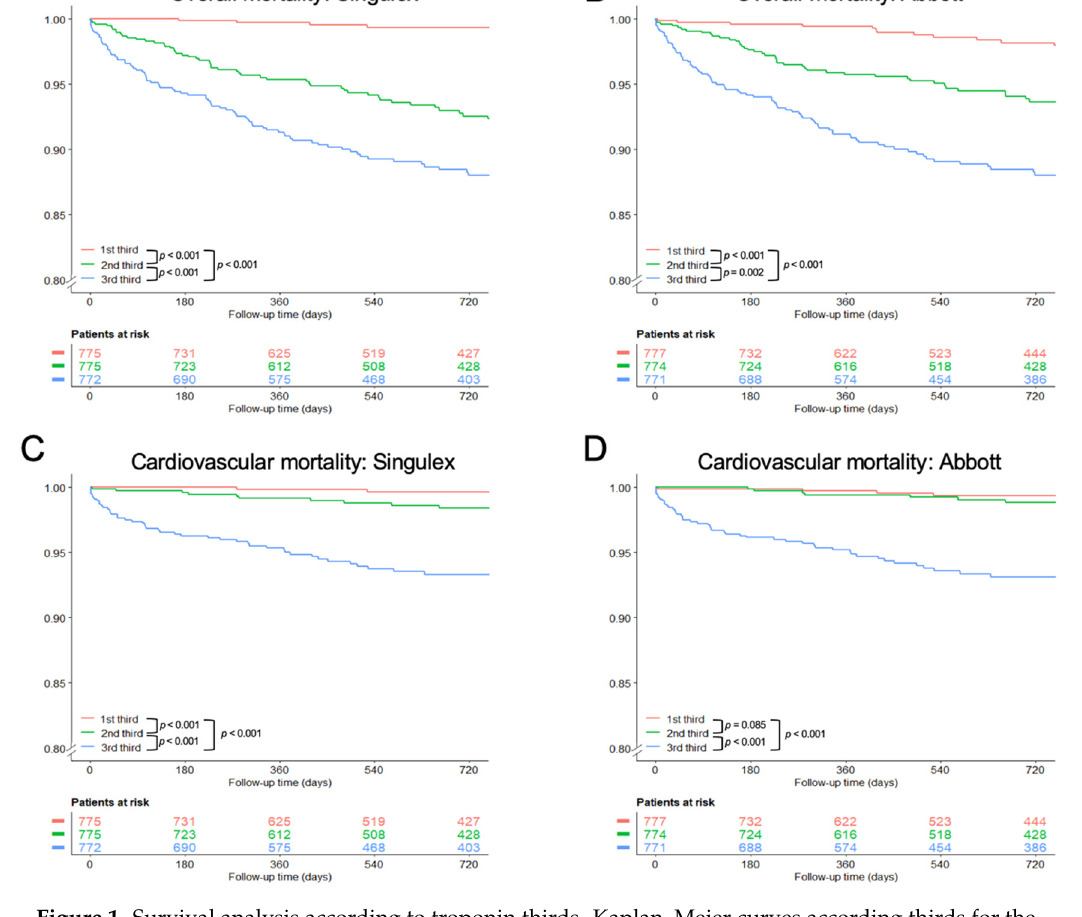
Figure 1. Survival analysis according to troponin thirds. Kaplan–Meier curves according thirds for the endpoints overall ( A , B ) and cardiovascular mortality ( C , D ). p stands for p -value of the log-rank